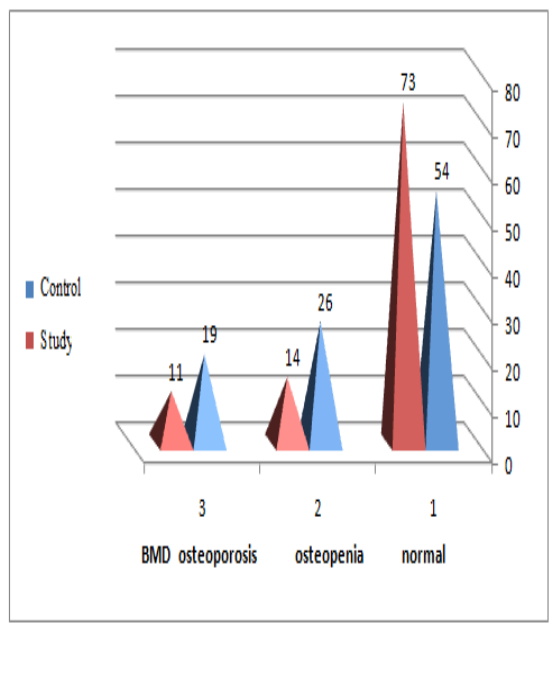
Figure 1: Percentages of osteopenia and osteoporosis in the study and control